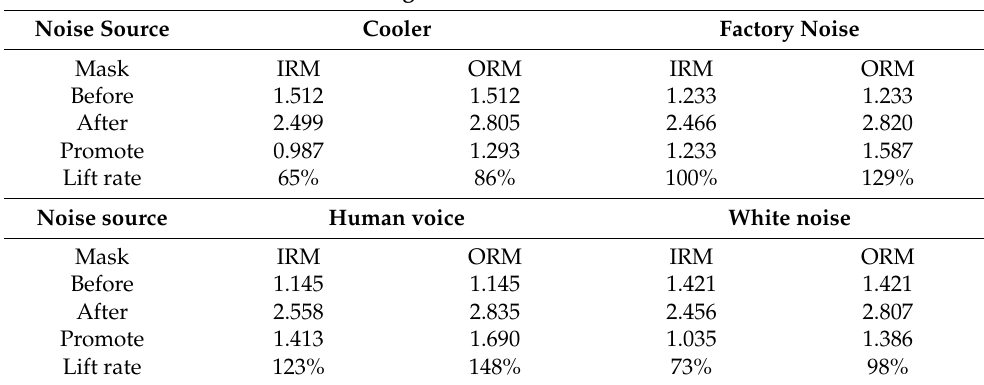
Table 10. Different ratio of noise reduction effect.